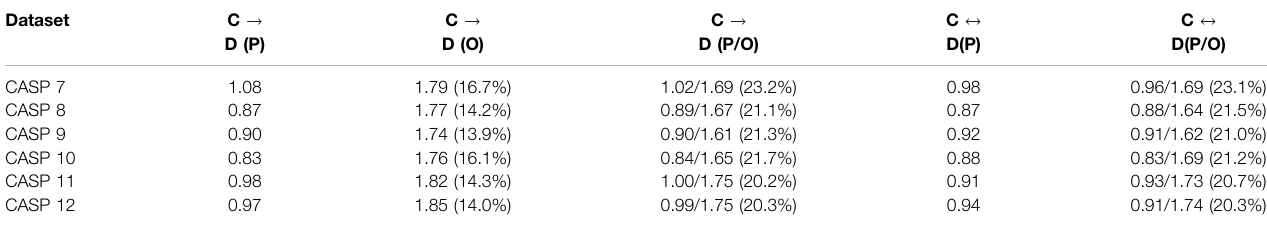
TABLE 4| Comparison betweenCoordinates toDesign(C → D)andreversiblelearning(C ↔ D)onCASP 7 – 12.Thelettersinthebracketsrepresentthedataconsidered by the loss function. P denotes PSSM, O denotes one-hot encoding of the sequence and P/O implies both data are utilized. We report the KL-divergence scores of the PSSM, the sequence or both. The accuracy of the sequence is depicted in brackets where applicable. Dataset